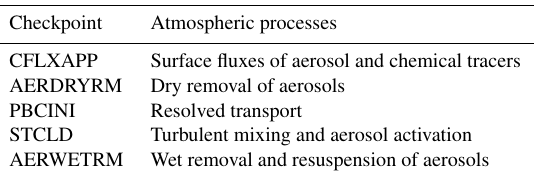
Table 2. For the dust budget analysis example in Sect. 6.1: at- mospheric processes corresponding to increments diagnosed at the checkpoints selected in the namelist shown in Table